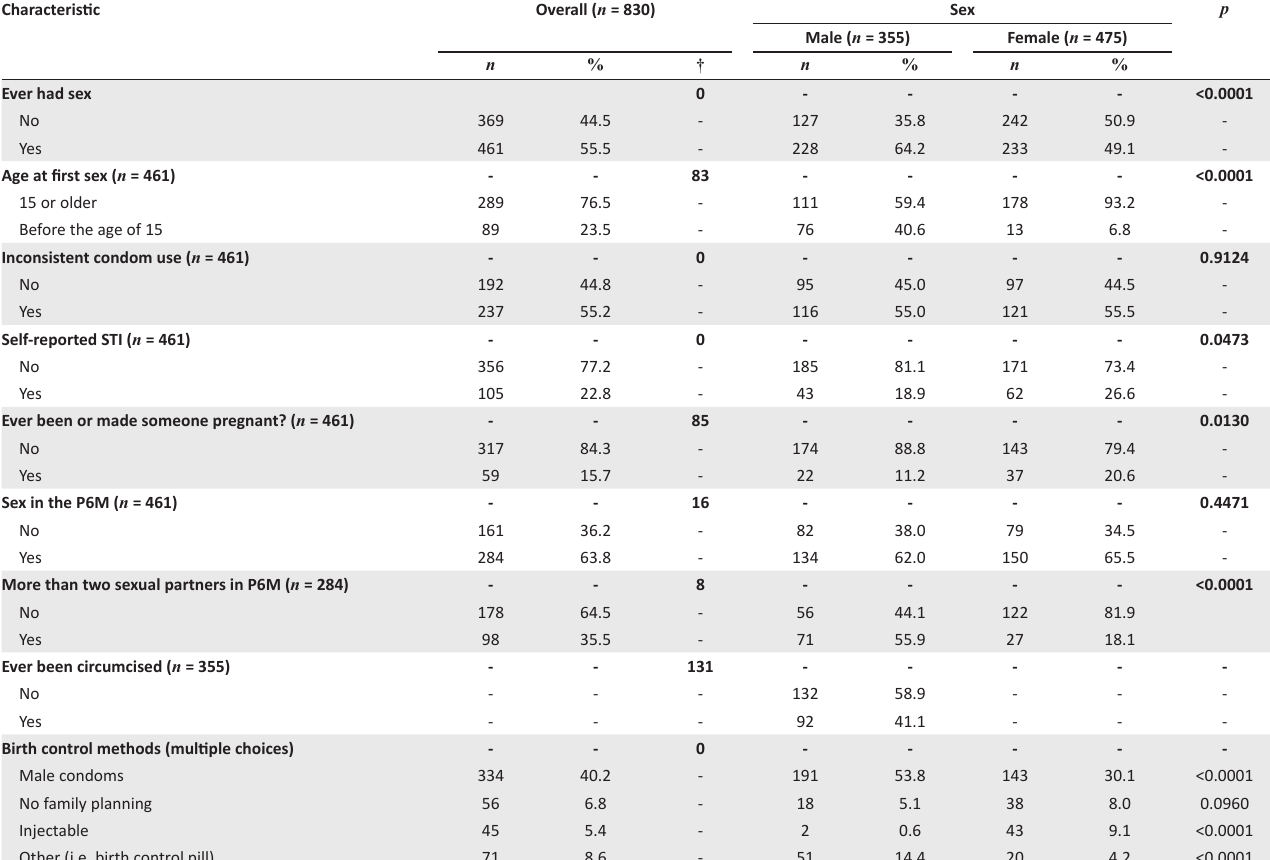
TABLE 3: Sexual and reproductive health of the male and female Botsha Bophelo Adolescent Health Study participants ( N = 830). Characteristic